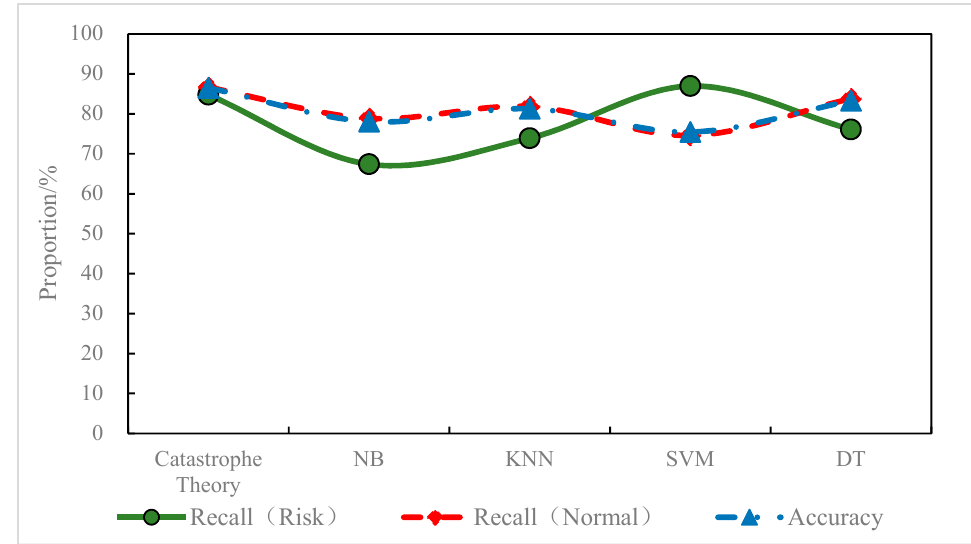
Figure 11. Prediction accuracy of different models for regional status.